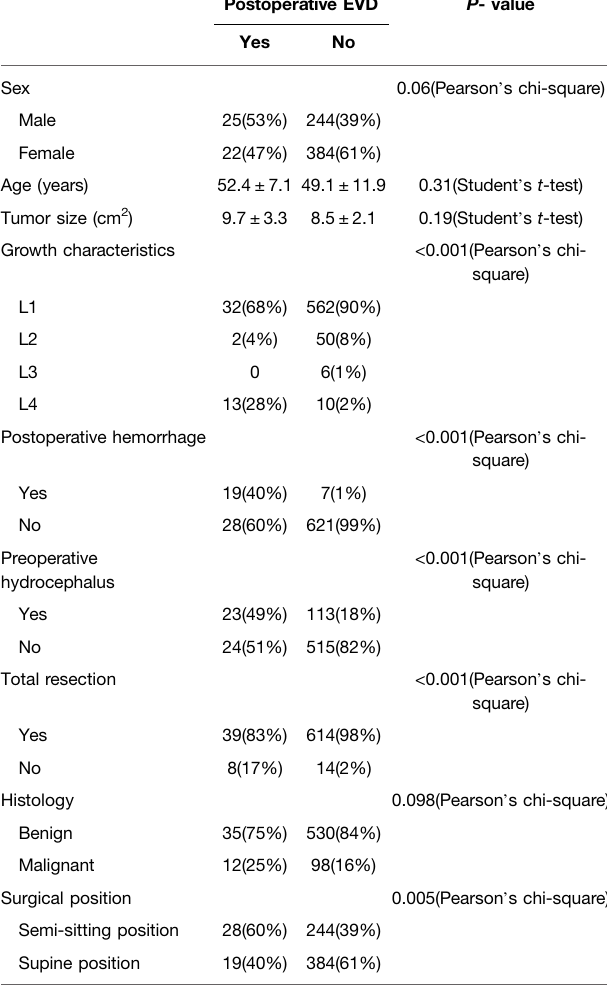
TABLE 4 | Summary of the factors with postoperative EVD. TABLE 5 | Univariate and multivariate analyses of the association between postoperative EVD and factors.